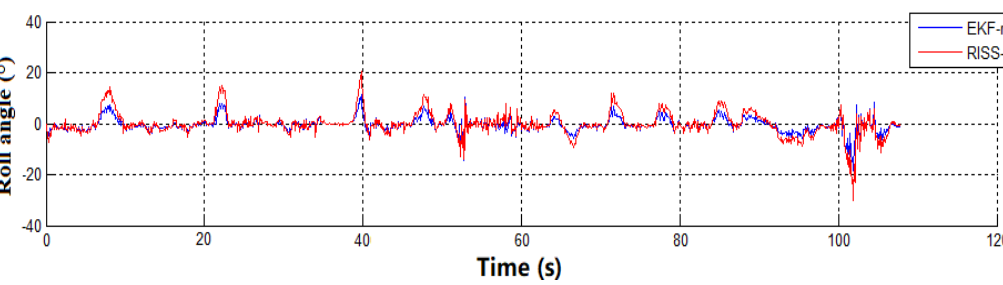
Figure 5. EKF-RISS roll angle